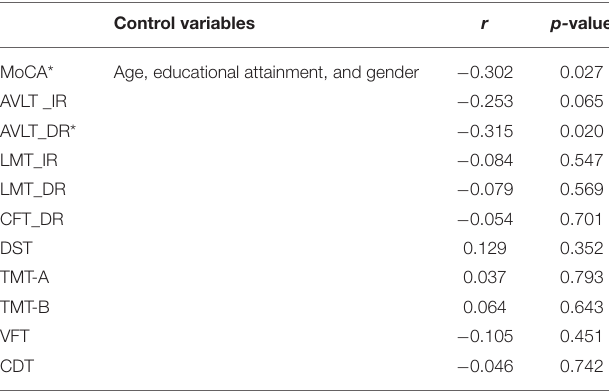
TABLE 2 | Partial correlations of plasma clusterin concentrations with neuropsychological tests in T2DM patients with MCI. Control variables r p-